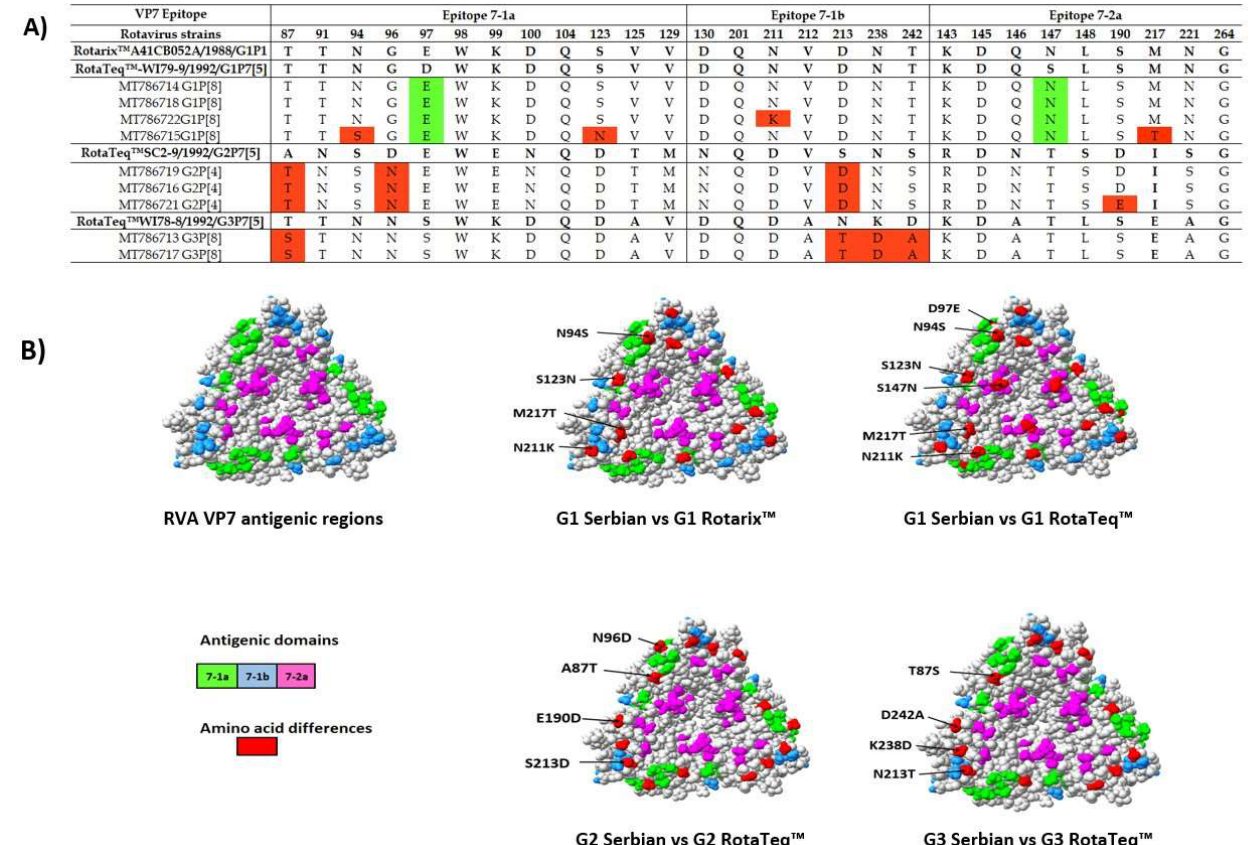
Figure 6. ( A ) Alignment of the amino acid residues in VP7 antigenic epitopes of the rotavirus strains circulating in Vojvodina, Serbia with those of the Rotarix™ and RotaTeq™ vaccines. Alignment of the amino acid residues defining the neutralization domains of the VP7 protein (7-1a, 7-1b, and 7-2a) of rotavirus strains analyzed. ( B ) Surface representation of VP7 trimer (Protein Data Bank (PDB) accession 3FMG). Antigenic epitopes 7-1a, 7-1b, and 7-2 are marked in green, blue, and purple colors, respectively. Red color shows surface exposed residues which differ between our vaccine strains.